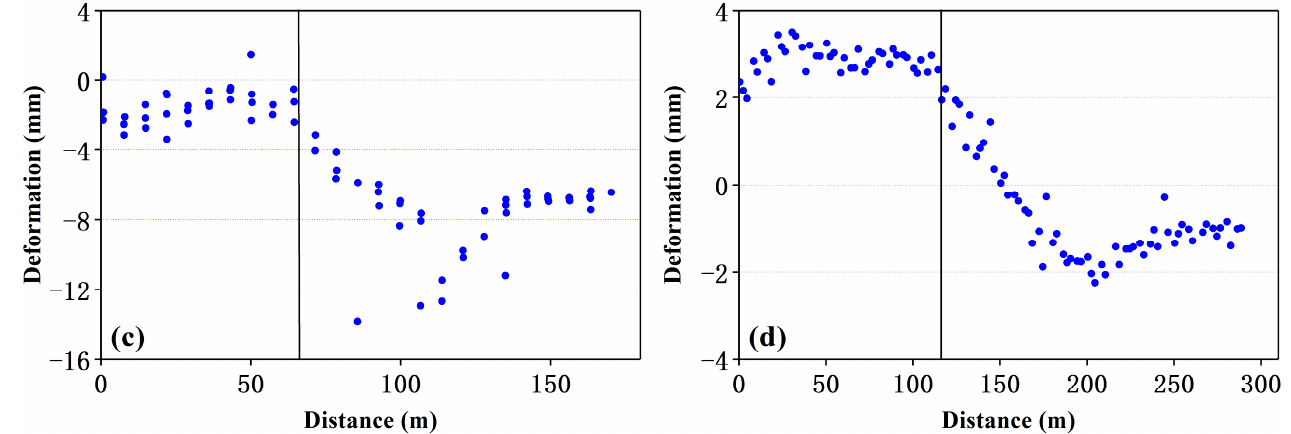
Figure 10. Inhomogeneous deformation of structural faults. ( a ) is part of Newport–Inglewood Fault and ( b ) is near San Bernardino Basin; ( c , d ) is the corresponding deformation rate extracted along the profile (black solid line indicates fault location).